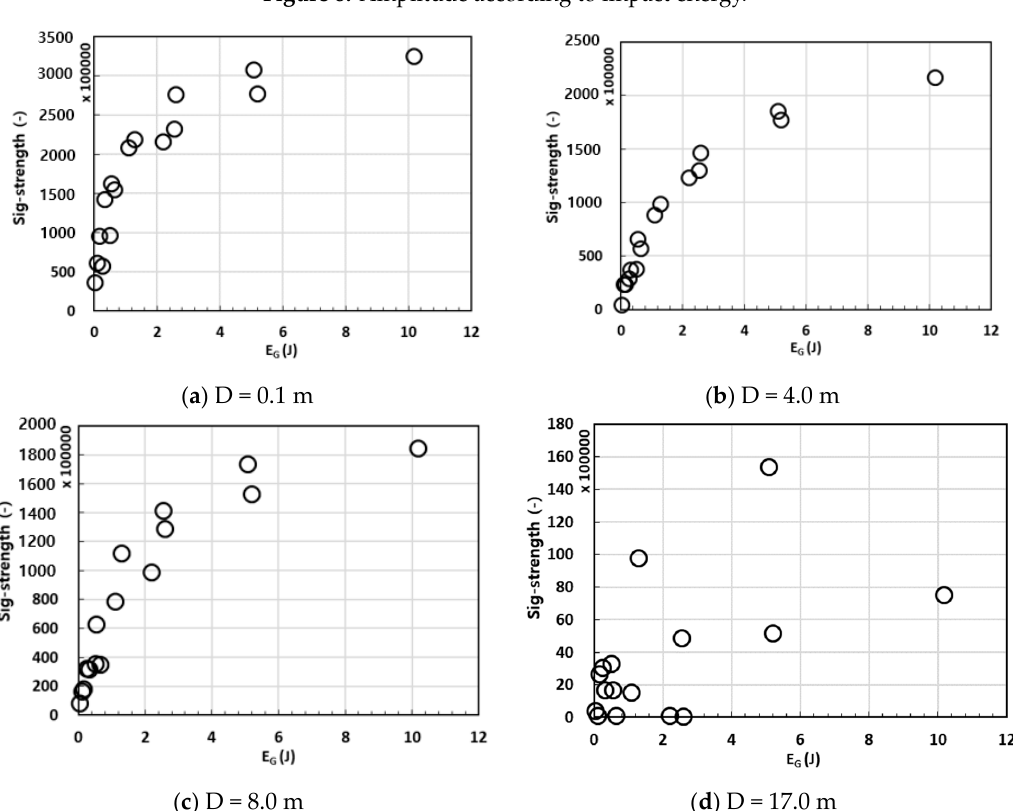
Figure 8. Amplitude according to impact energy.